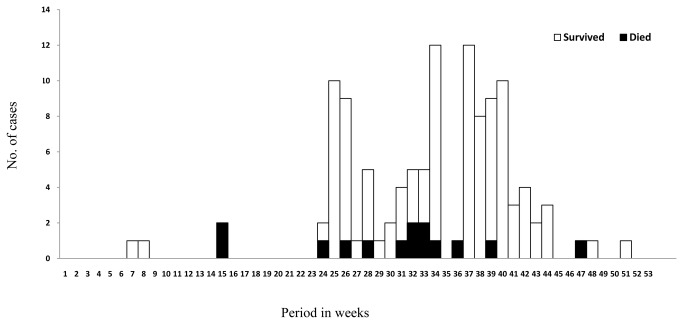
The epidemic curve of cases of SFTSV infection, by weekly periods of symptom onset, starting on June 2010 and continuing through December 2011.